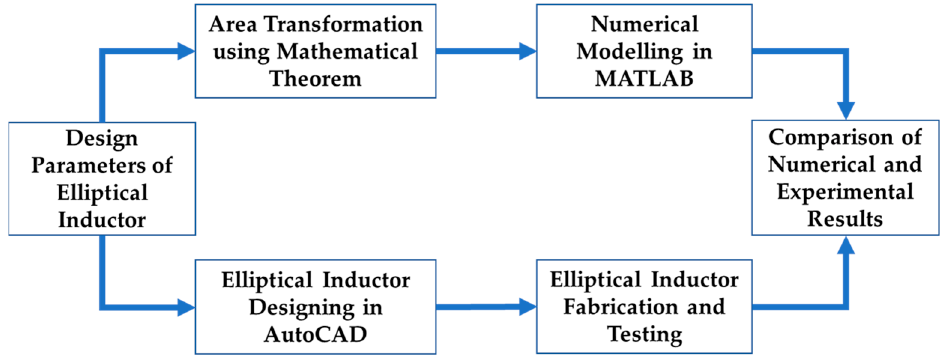
Figure 1. Overall workflow to optimize the design of elliptical inductors.